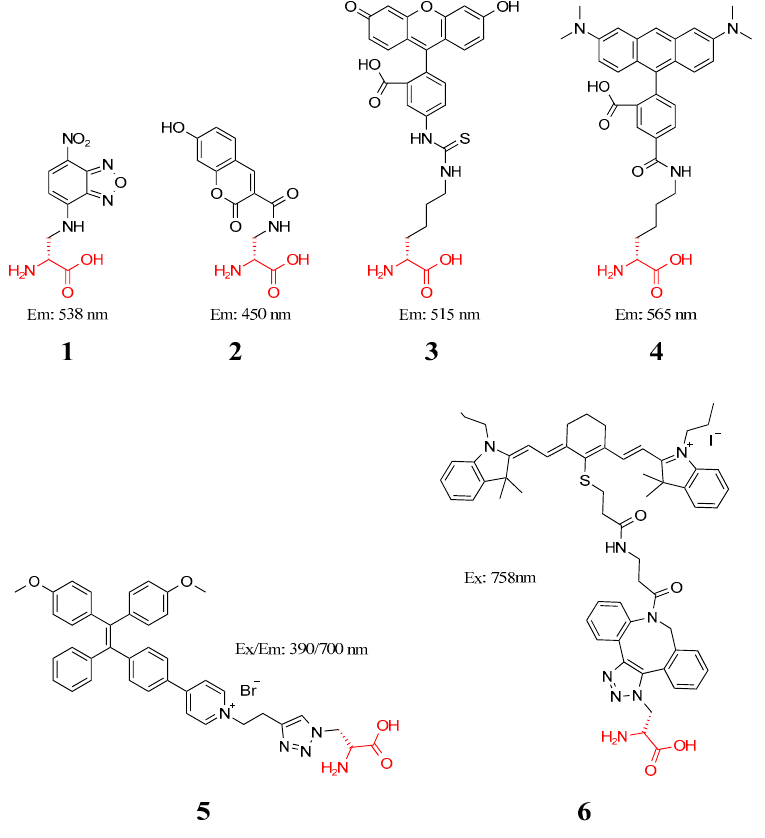
Figure 2. Structure of probes 1 – 6 .